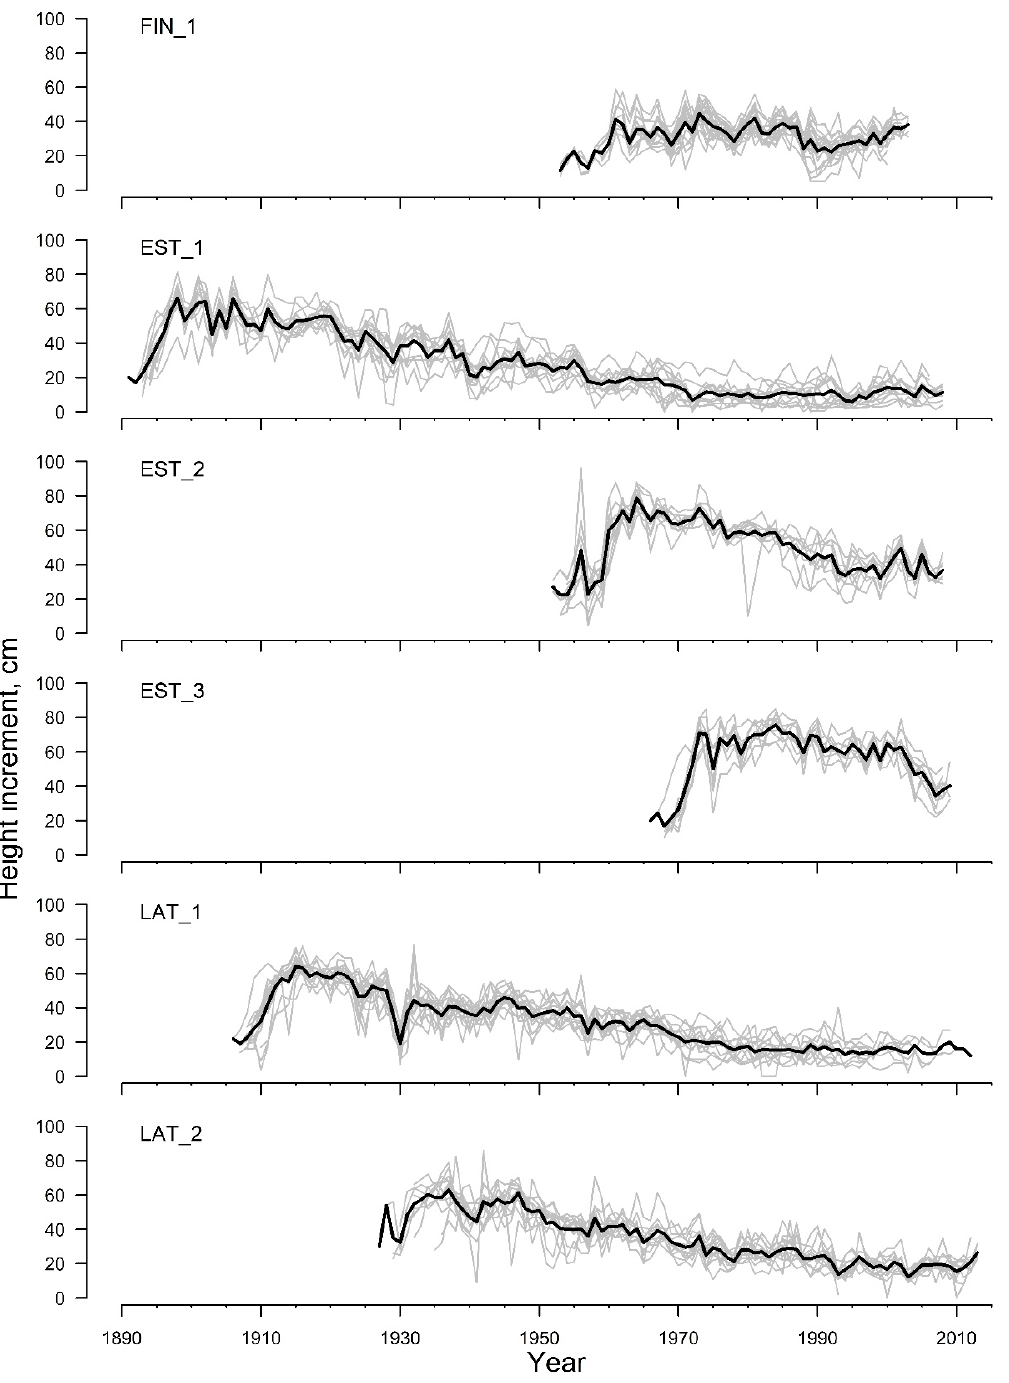
Figure 2. Cross-dated time series of height increment of Scots pine from conventionally managed stands in Finland, Estonia and Latvia and the mean series (bold line) of the datasets of the studied stands.